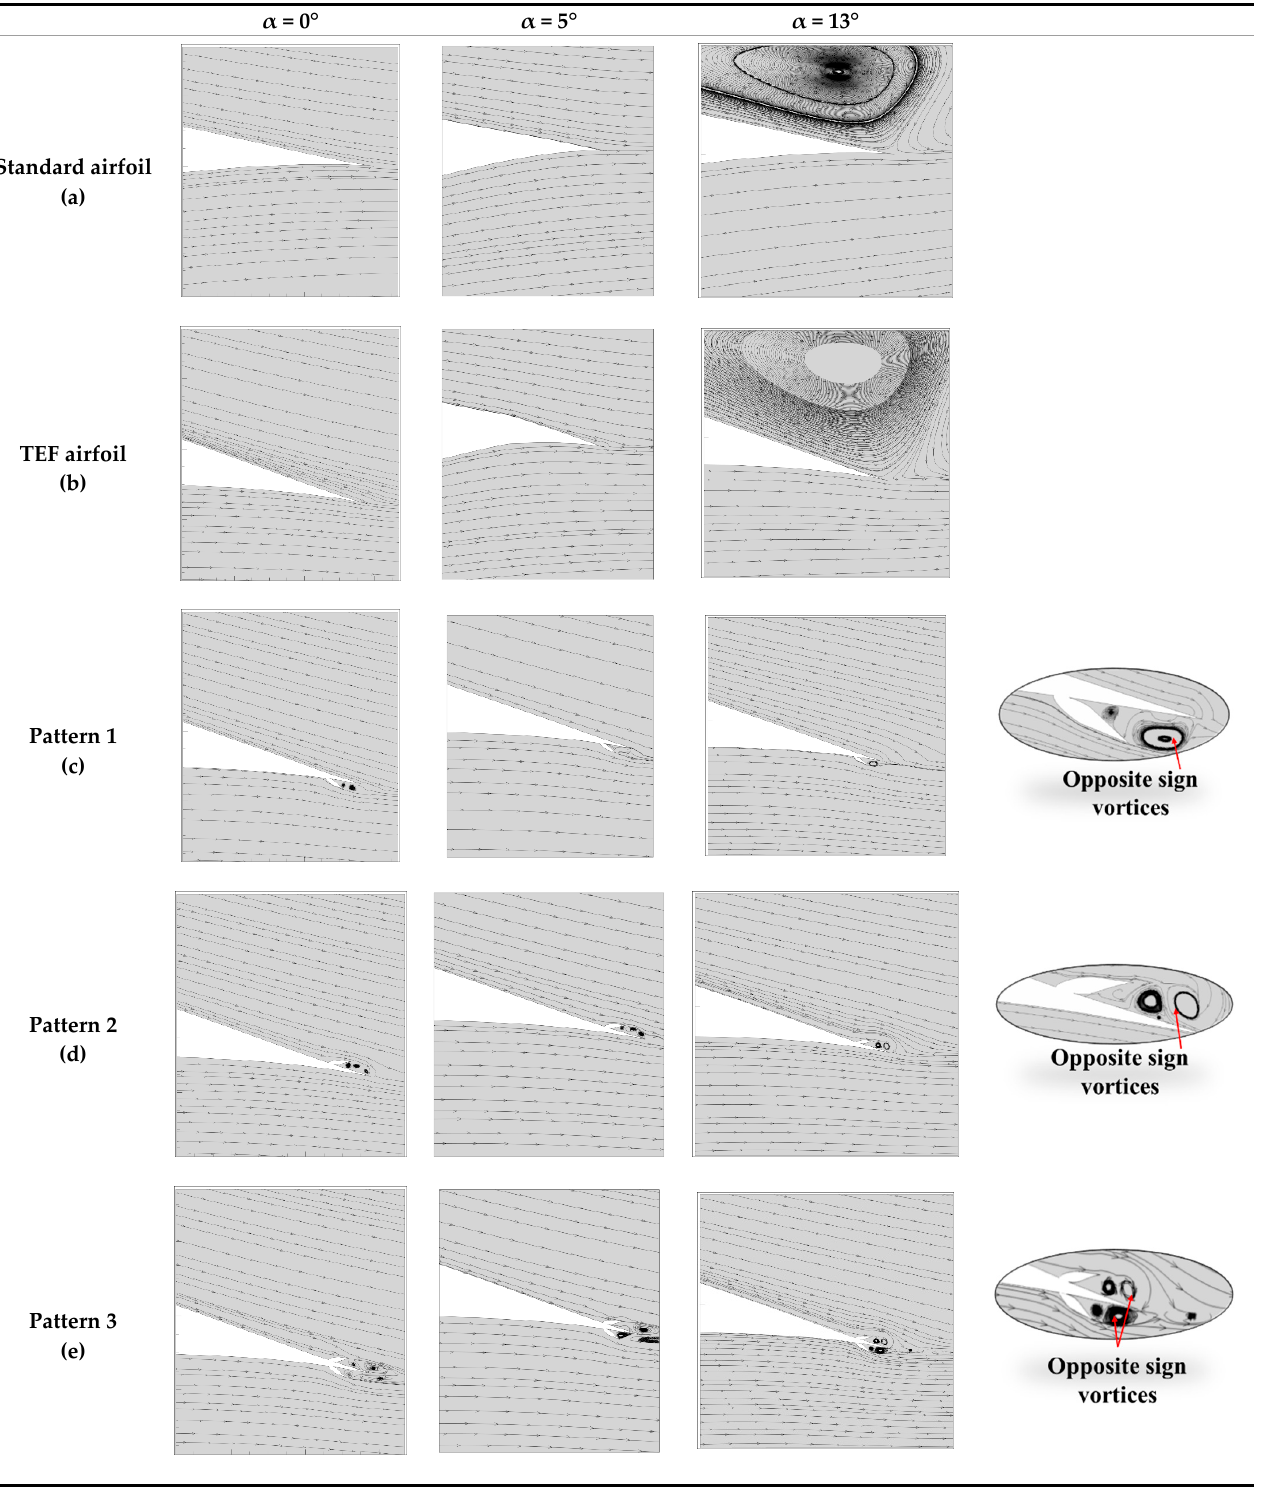
Figure 9. Comparison of streamline distribution of the TEF airfoil with/without Micro-Tab at three different positions, ( a ) Standard airfoil, ( b )TEF airfoil, ( c ) Pattern 1, ( d ) Pattern 2, ( e ) Pattern 3.